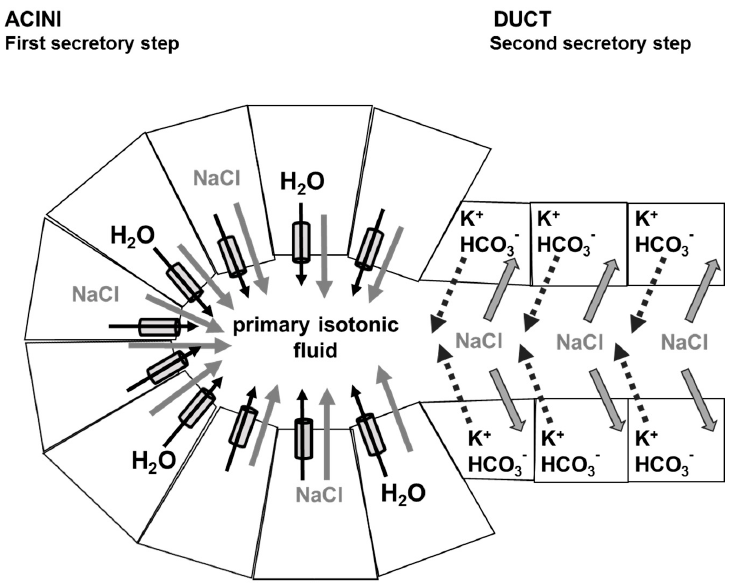
Figure 2. Physiology of saliva secretion and role of AQP5. During the first secretory step, acinar